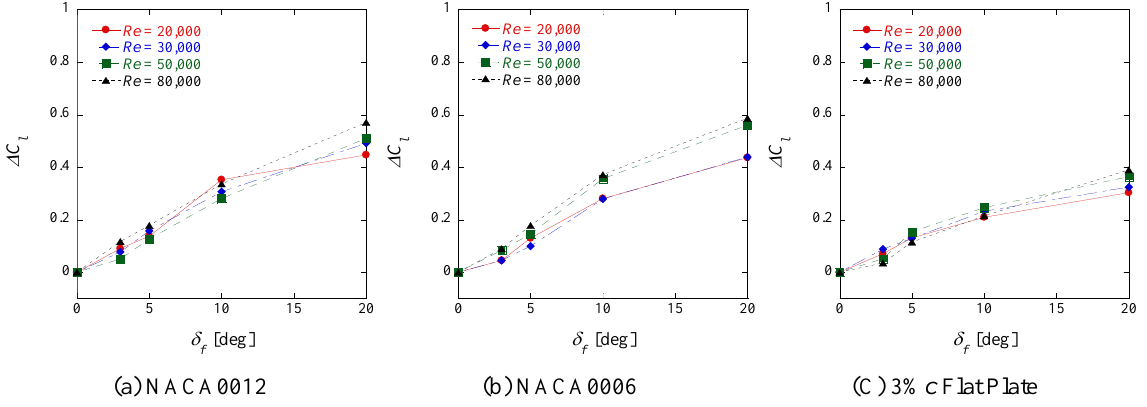
Fig. 10 Control surface effectiveness at  = 6 deg in the Reynolds number range from Re = 20,000 to Re = 80,000. The control surface effectiveness of 3% c flat plate becomes smaller than those of NACA0012 and NACA0006 since the bursts of the leading edge separation bubble